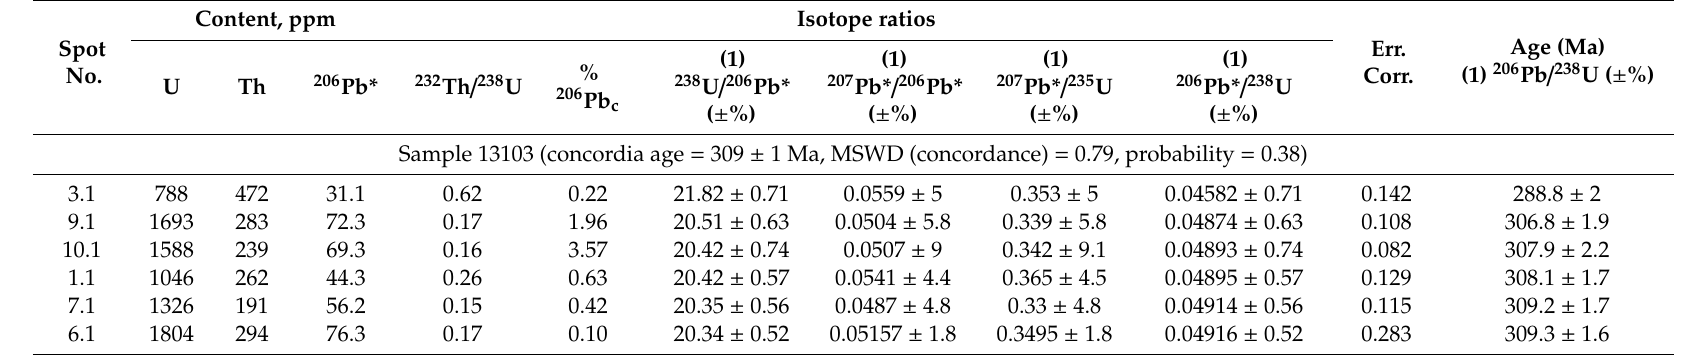
Table A3. Results of geochronological studies of the collisional granites of the Kara